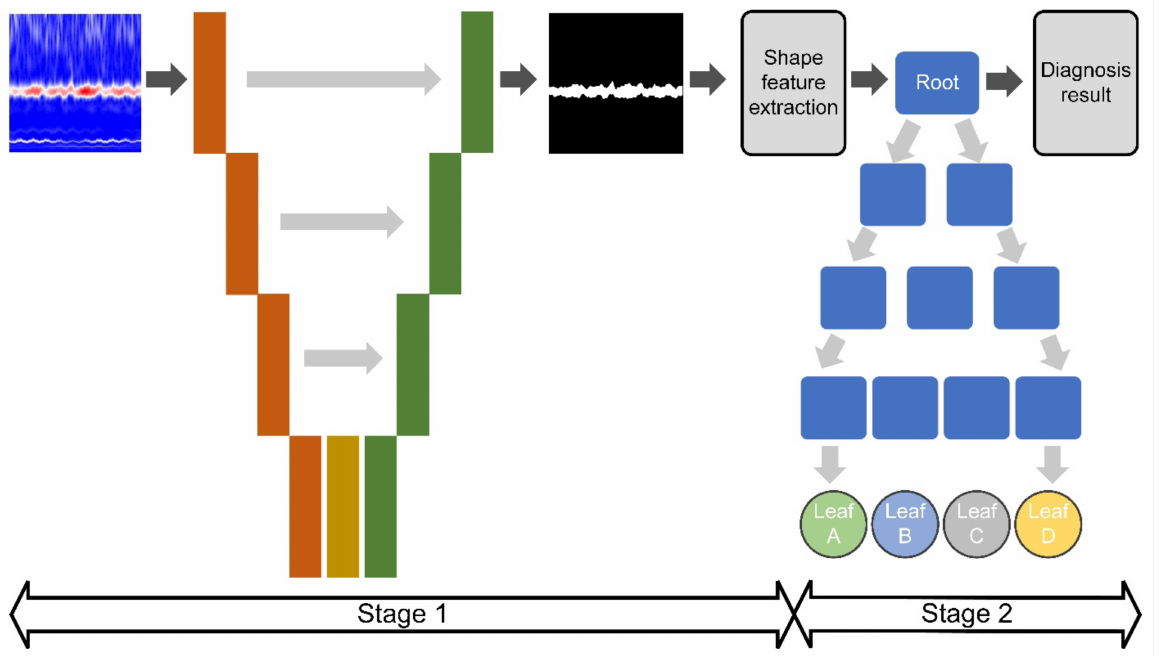
Figure 2. Architecture of the proposed two-stage